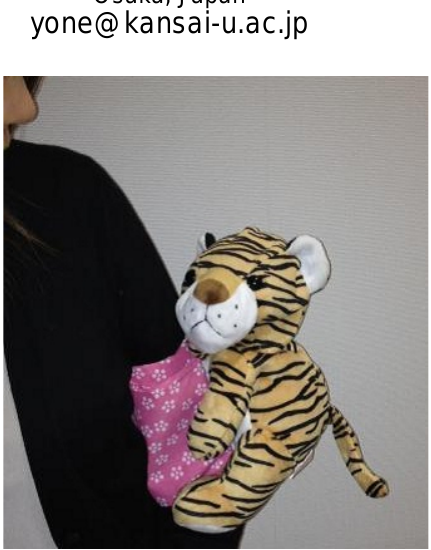
Figure 1: System